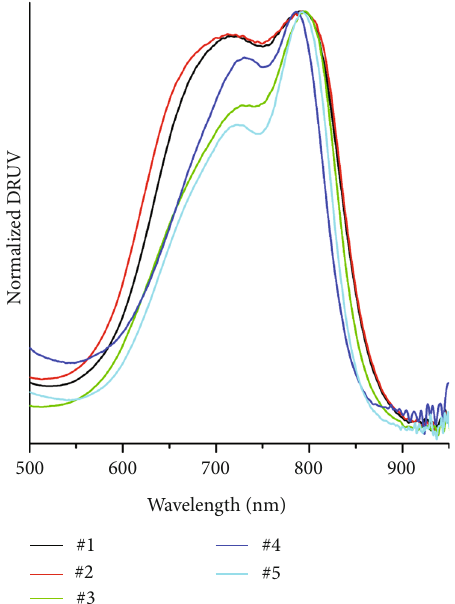
Figure 4: Normalized solid-state absorption spectra of dye 13 obtained from the di ff erent adsorption methodologies (#1-#5), where #1: dye concentration — 5.0 mM, DCA concentrations —